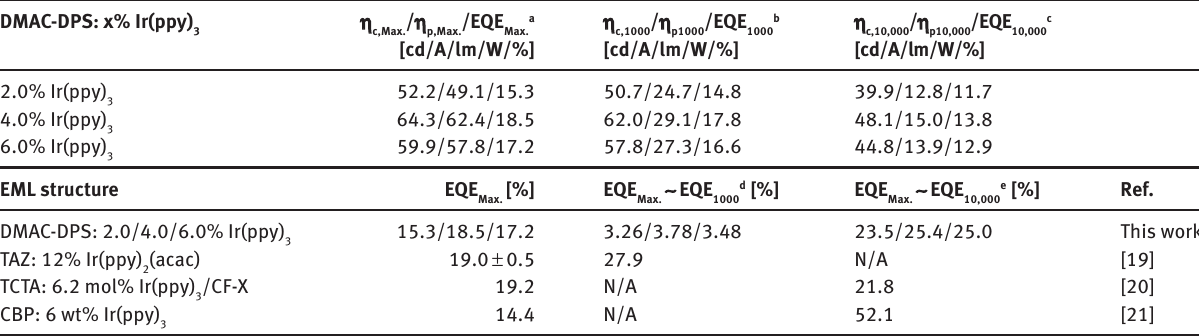
Table 2: Summary EL performance and roll-off ratio of the Ph-OLEDs in this paper with representative devices based on Ir(ppy) Ir(ppy) 2